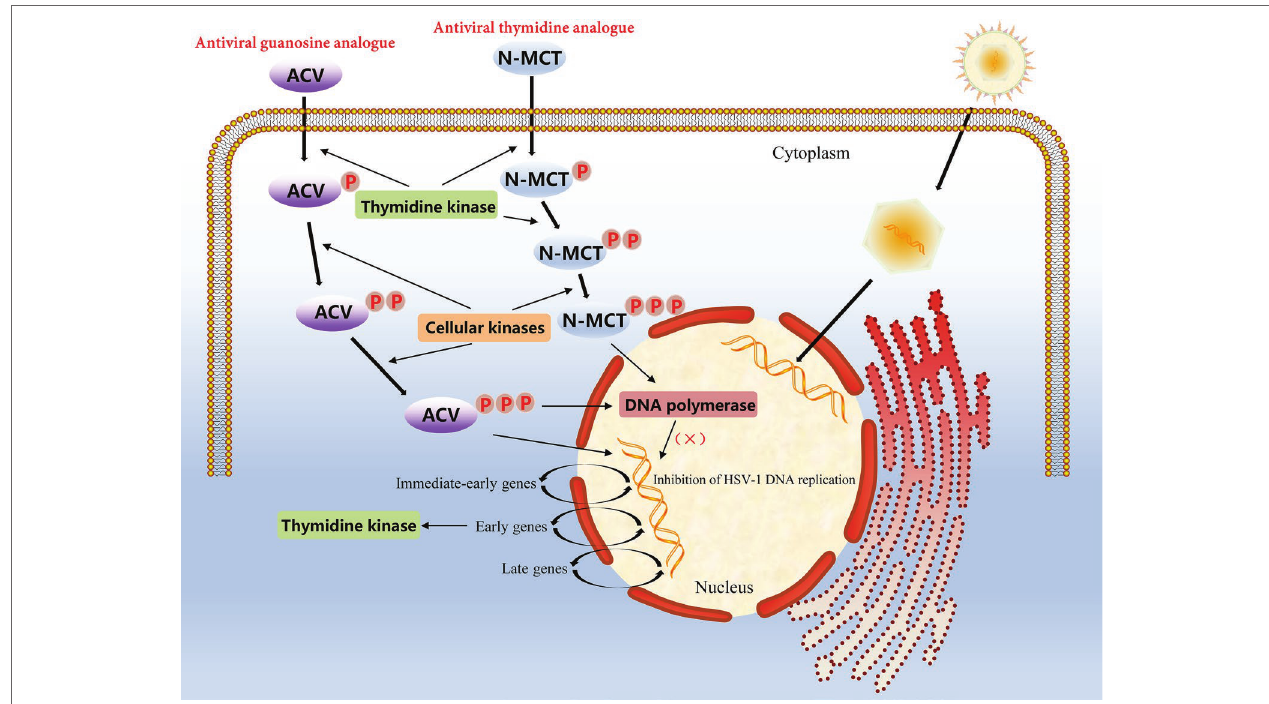
FIGURE 2 | Molecular mechanism of action of the antiviral guanosine analogue ACV and the thymidine analogue N-MCT in HSV-1 infected